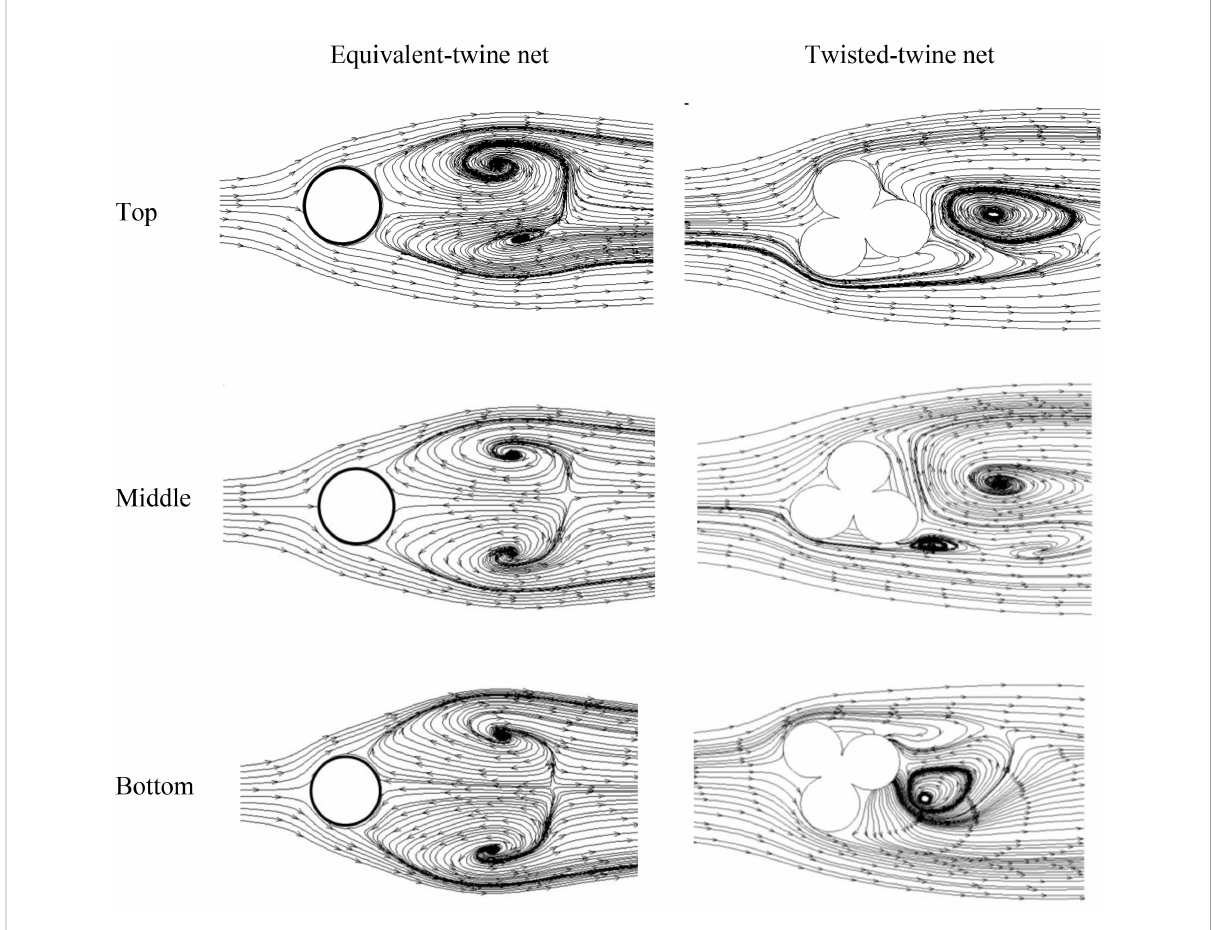
FIGURE 9 Streamlines around the equivalent net twines (left column) and the twisted net twines (right column) at different planes of the nets for Re =